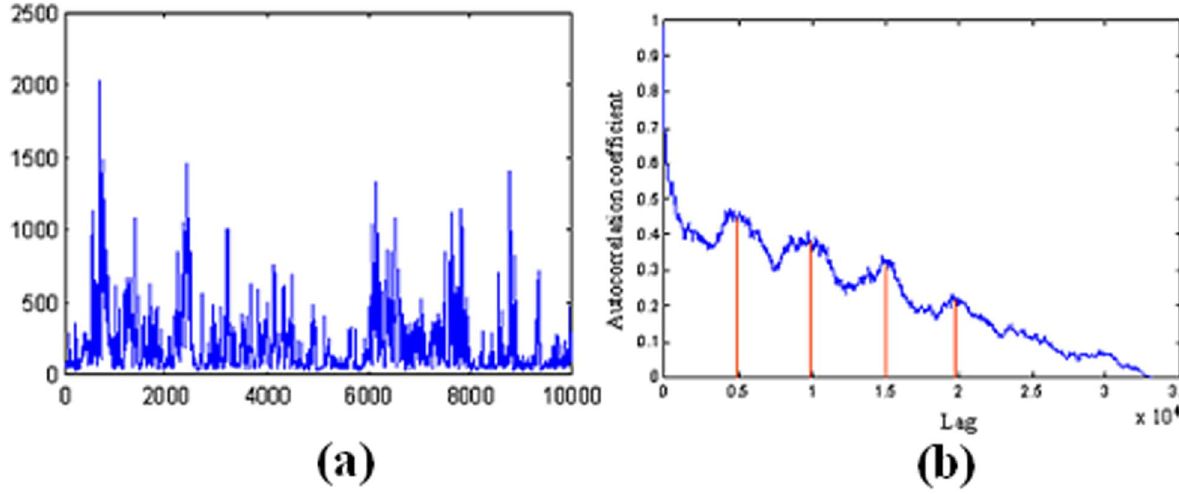
Figure 6. (a) The mean value of the AE index time series. (b) The correlogram of the mean value of the AE index signal.